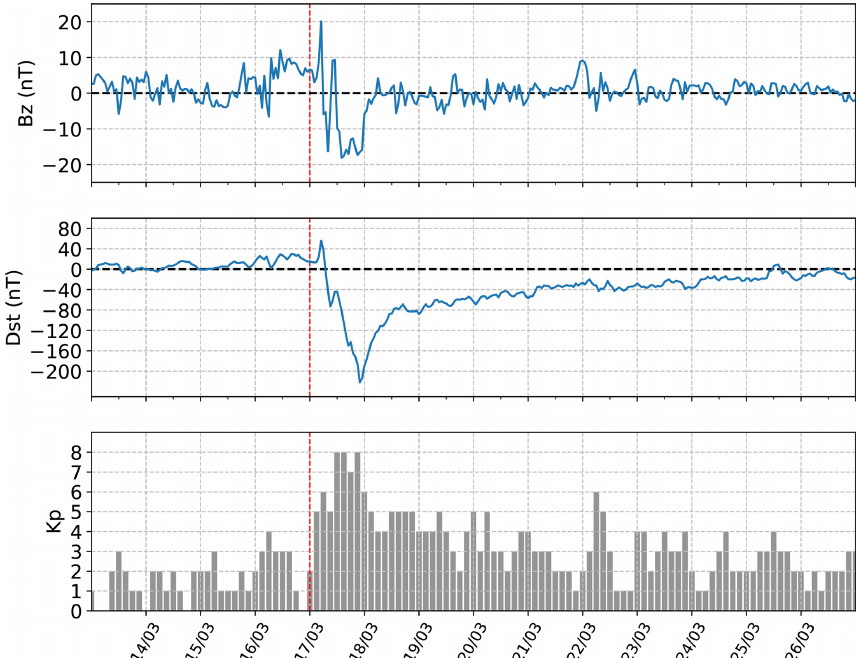
Figure 5. The vertical component of the interplanetary magnetic field ( B z ) and the Dst and Kp geomagnetic indices between 13 and 27 March 2015. The vertical dashed red line in all the plots indicates the day that the 2015 St. Patrick’s Day storm occurred (17 March